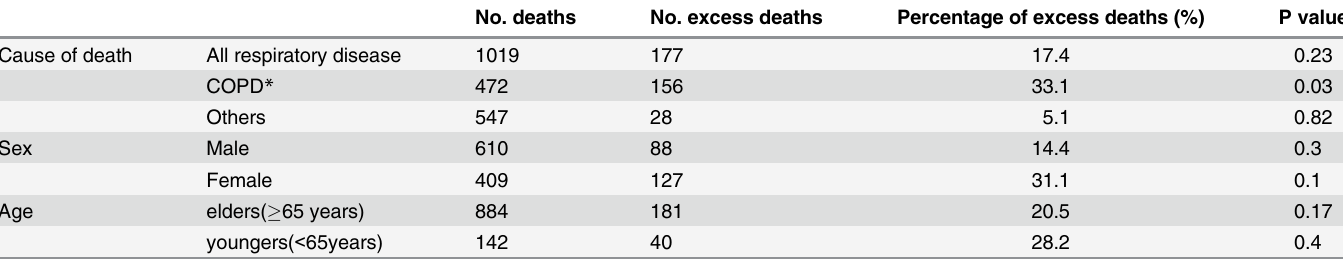
Table 5. Impact of influenza-like illness on deaths by disease, sex, and